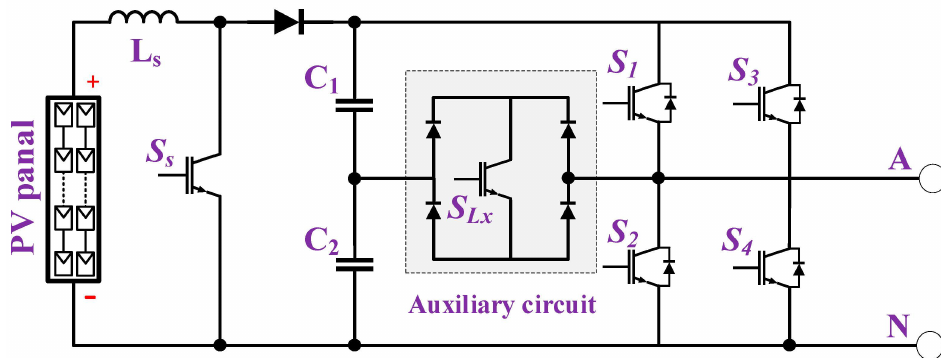
Figure 6. A single submodule of a CHB with an auxiliary circuit [56].